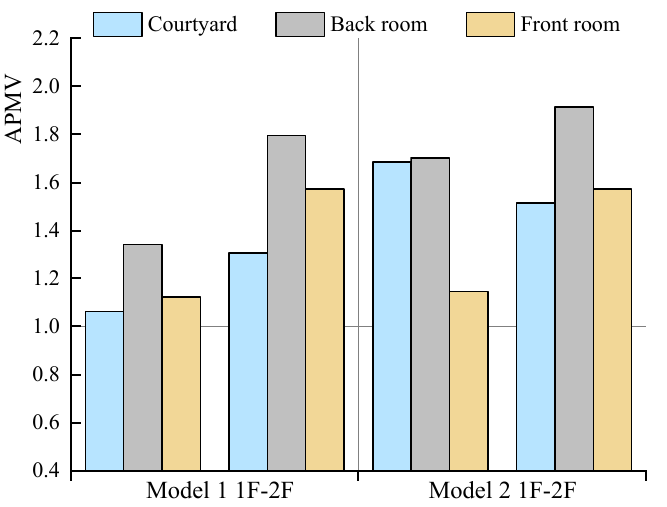
Figure 8. APMV values in Models 1–2 at 12:00 at 1.2 m height on each floor.